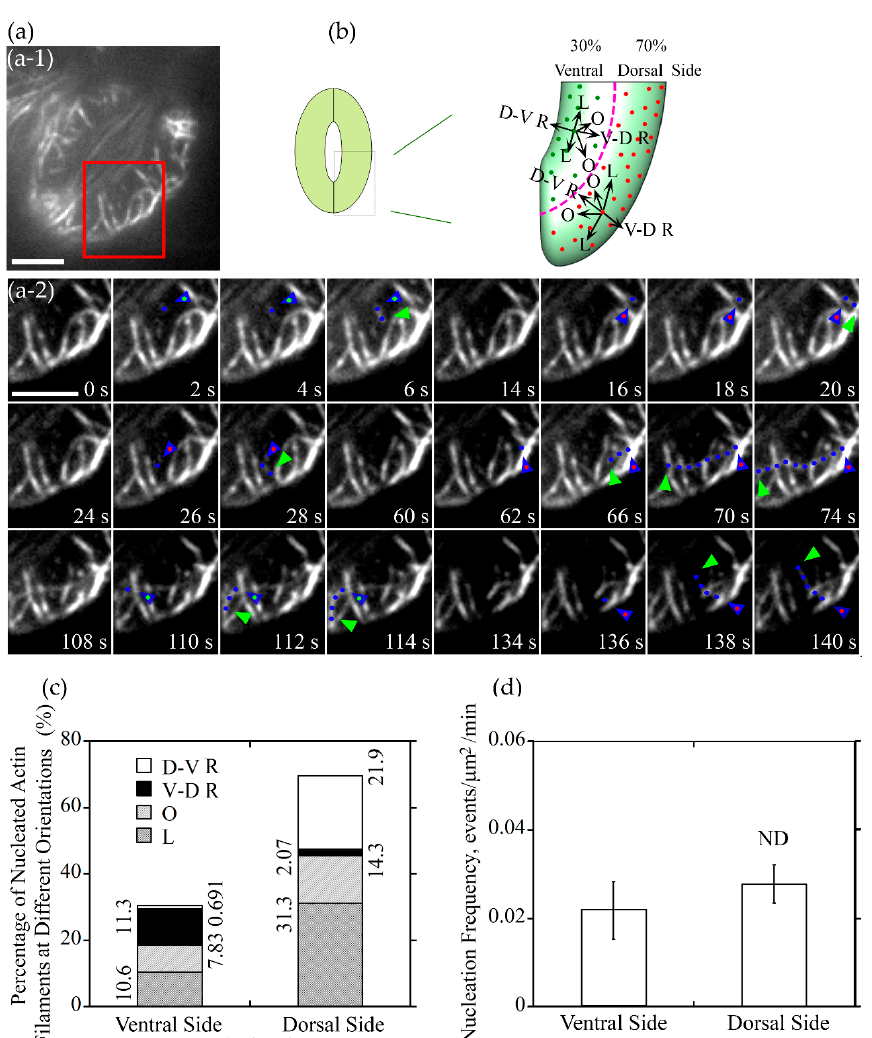
Figure 4. Actin nucleation occurs at both of dorsal side and ventral side of guard cells, and the majority of them elongated along the longitudinal orientation in closed stomata. ( a ) Dynamics of actin nucleation and elongation of single actin filaments in guard cell of closed stomata in wild type (WT). ( a - 1 ) Overview of the closed stomata expressing GFP-ABD2-GFP, the red box marked the region of interest. ( a - 2 ) An enlarged view of time-lapse images of actin nucleation and elongating direction in the region of interest in ( a - 1 ). Blue triangles with red dot inside indicate the nucleation sites or the starting points of the elongating actin filaments in the dorsal side of guard cells, and blue triangles with green dot inside indicate the nucleation sites or the starting points of the elongating actin filaments in the ventral side of guard cells. Blue dots indicate the elongating actin filaments. Green triangles indicate the newly elongated direction of actin filaments. Bar = 5 µ m. ( b ) Schematic diagram describing actin filaments of di ff erent orientations (D-V R, dorsal-to-ventral radial; V-D R, ventral-to-dorsal radial; O, oblique; L, longitudinal) in the dorsal side and ventral side of guard cells in closed stomata. The dotted pink line is the boundary between dorsal region and ventral region of the guard cell. Red and green dots represent actin nucleation sites in dorsal and ventral region of the guard cell, respectively. Arrows indicate the direction of the elongation of the actin filaments. ( c ) The proportion of actin filaments of each orientation (D-V R, dorsal-to-ventral radial; V-D R, ventral-to-dorsal radial; O, oblique; L, longitudinal) in the dorsal side and ventral side of guard cells in closed stomata. ( d ) Nucleation frequency per unit area showed no significant di ff erence between dorsal side and ventral side of guard cell in closed stomata. ND, no significant di ff erence. See Supplemental Movie 2 online for the entire series in ( a ). Bar = 5 µ